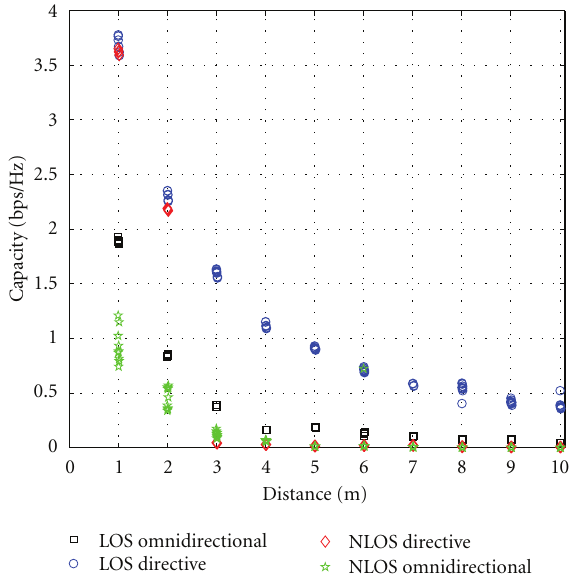
Figure 7: RMS delays spread at two levels.